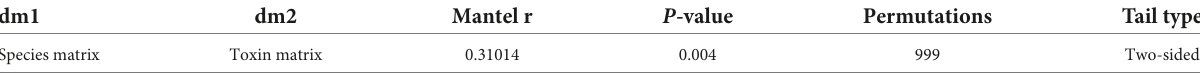
TABLE 2 Correlation of mantel test between gut microbiota and toxins after FMT. dm1 dm2 Mantel r P -value Permutations Tail type Species matrix Toxin matrix 0.31014 0.004 999